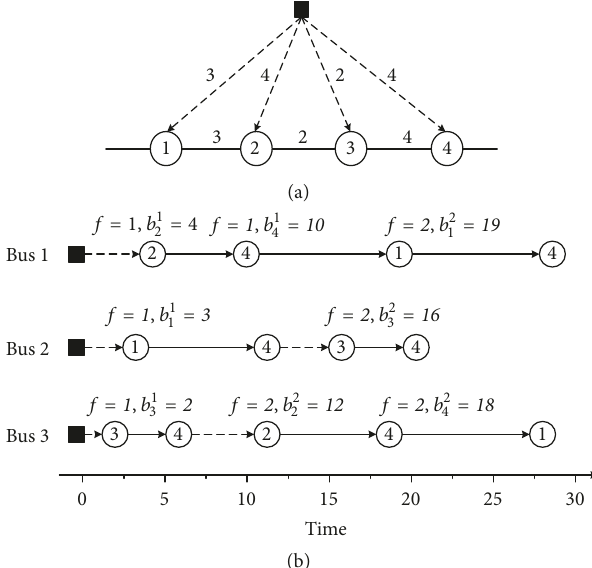
Figure 2: Illustration of bus bridging trips and pickups.